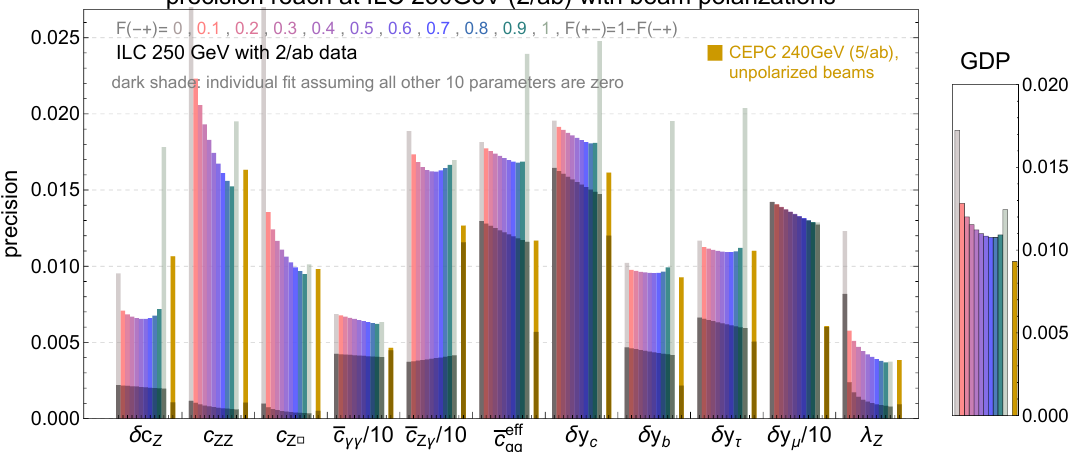
Figure 10 . One-sigma precision reach of ILC runs at 250 GeV with 2 ab (cid:0) 1 of integrated luminosity + ) = ( shared between P ( e 0 : 8 ; +0 : 3) and (+0 : 8 ; 0 : 3) beam polarization con(cid:12)gurations. The (cid:0) ; e (cid:0) (cid:0) corresponding fractions are denoted as F and F = 1 . For the sake of comparison, F ( +) (+ ) ( +) (cid:0) (cid:0) (cid:0) (cid:0) the constraints resulting from a CEPC run at 240 GeV with 5 ab (cid:0) 1 of integrated luminosity collected without beam polarization are also shown. The dark shades correspond to the constraints obtained when one single parameter is kept at the time, assuming all others vanish.